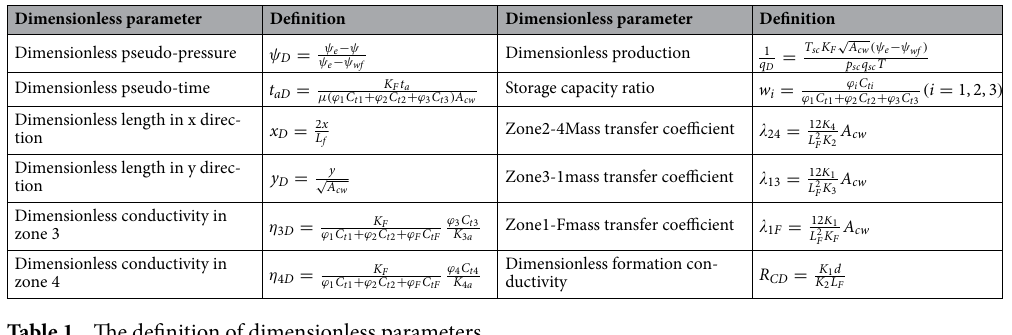
Table 1. The definition of dimensionless